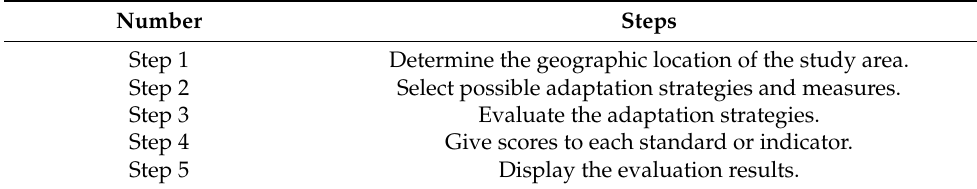
Table 3. An overview of five steps of the TEAM